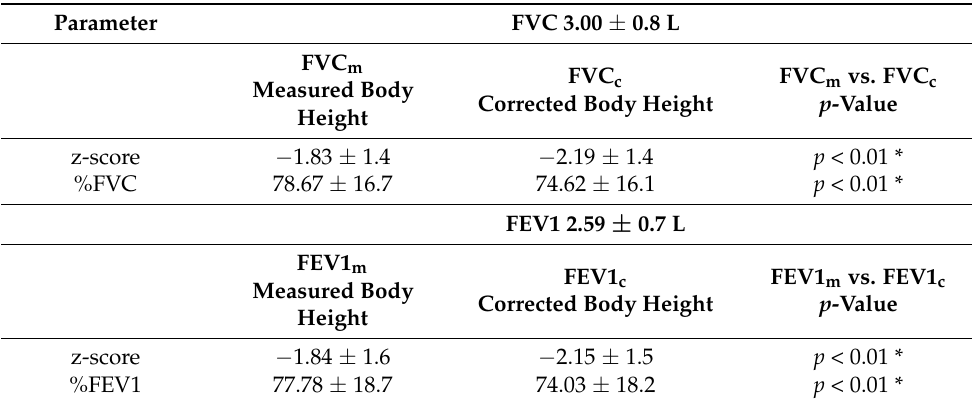
Table 3. The absolute FVC and FEV1 values, and values calculated for the measured vs. the corrected body height, N =